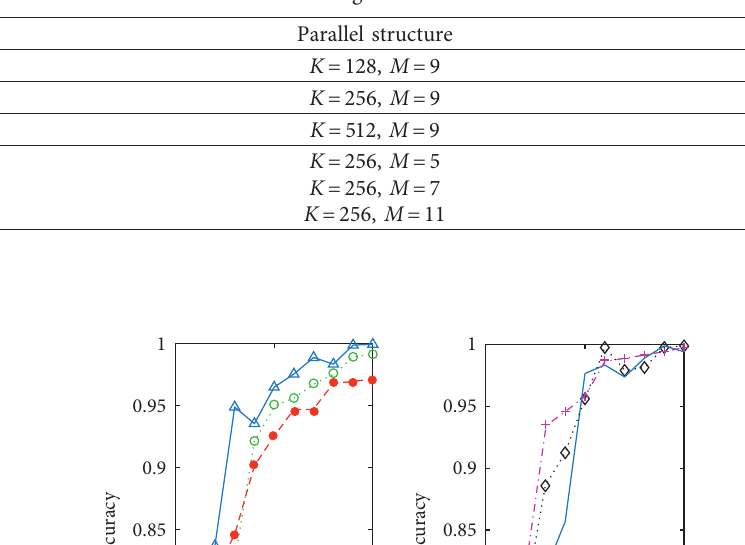
Table 4: Different configuration schemes of the network.